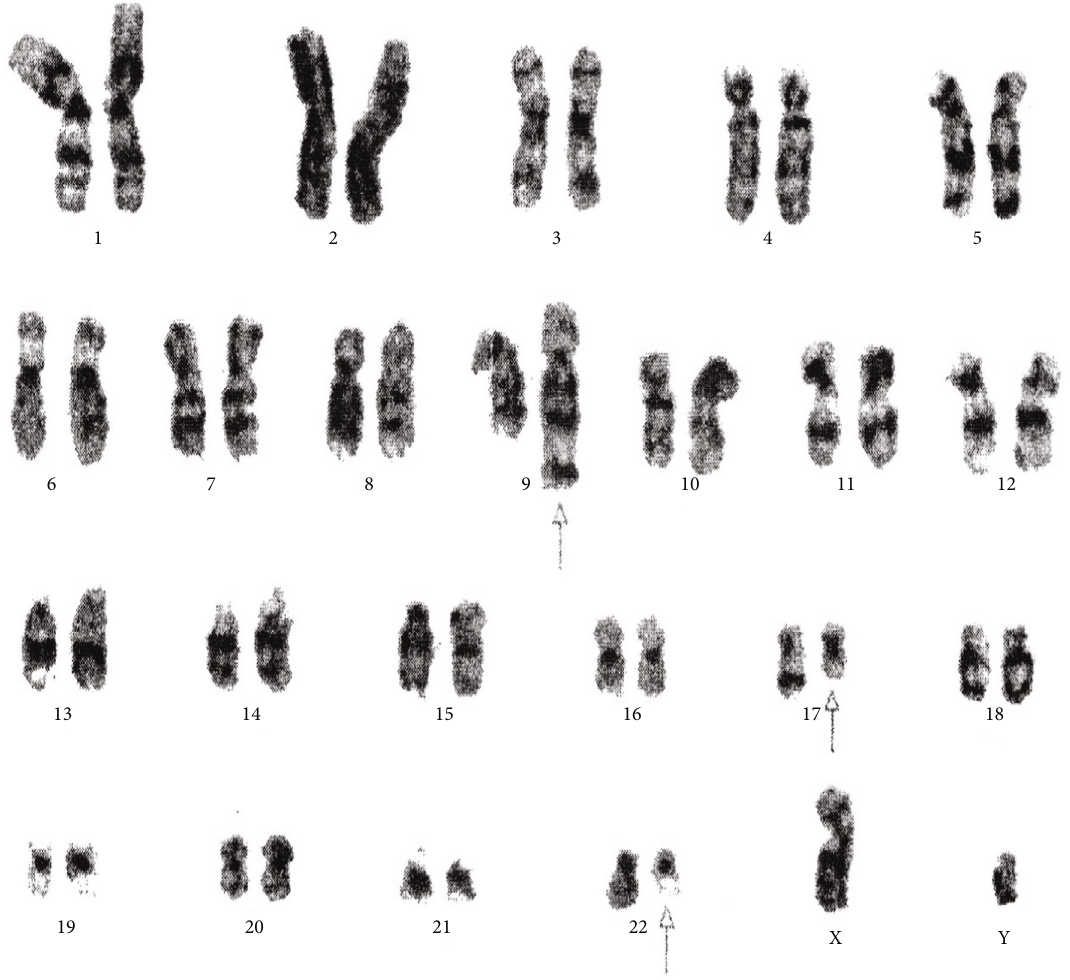
Figure 3: Cytogenetic analysis shows three-way complex variant translocations 46XY,t(9;17;22)(q34;q?11.2;q11.2)